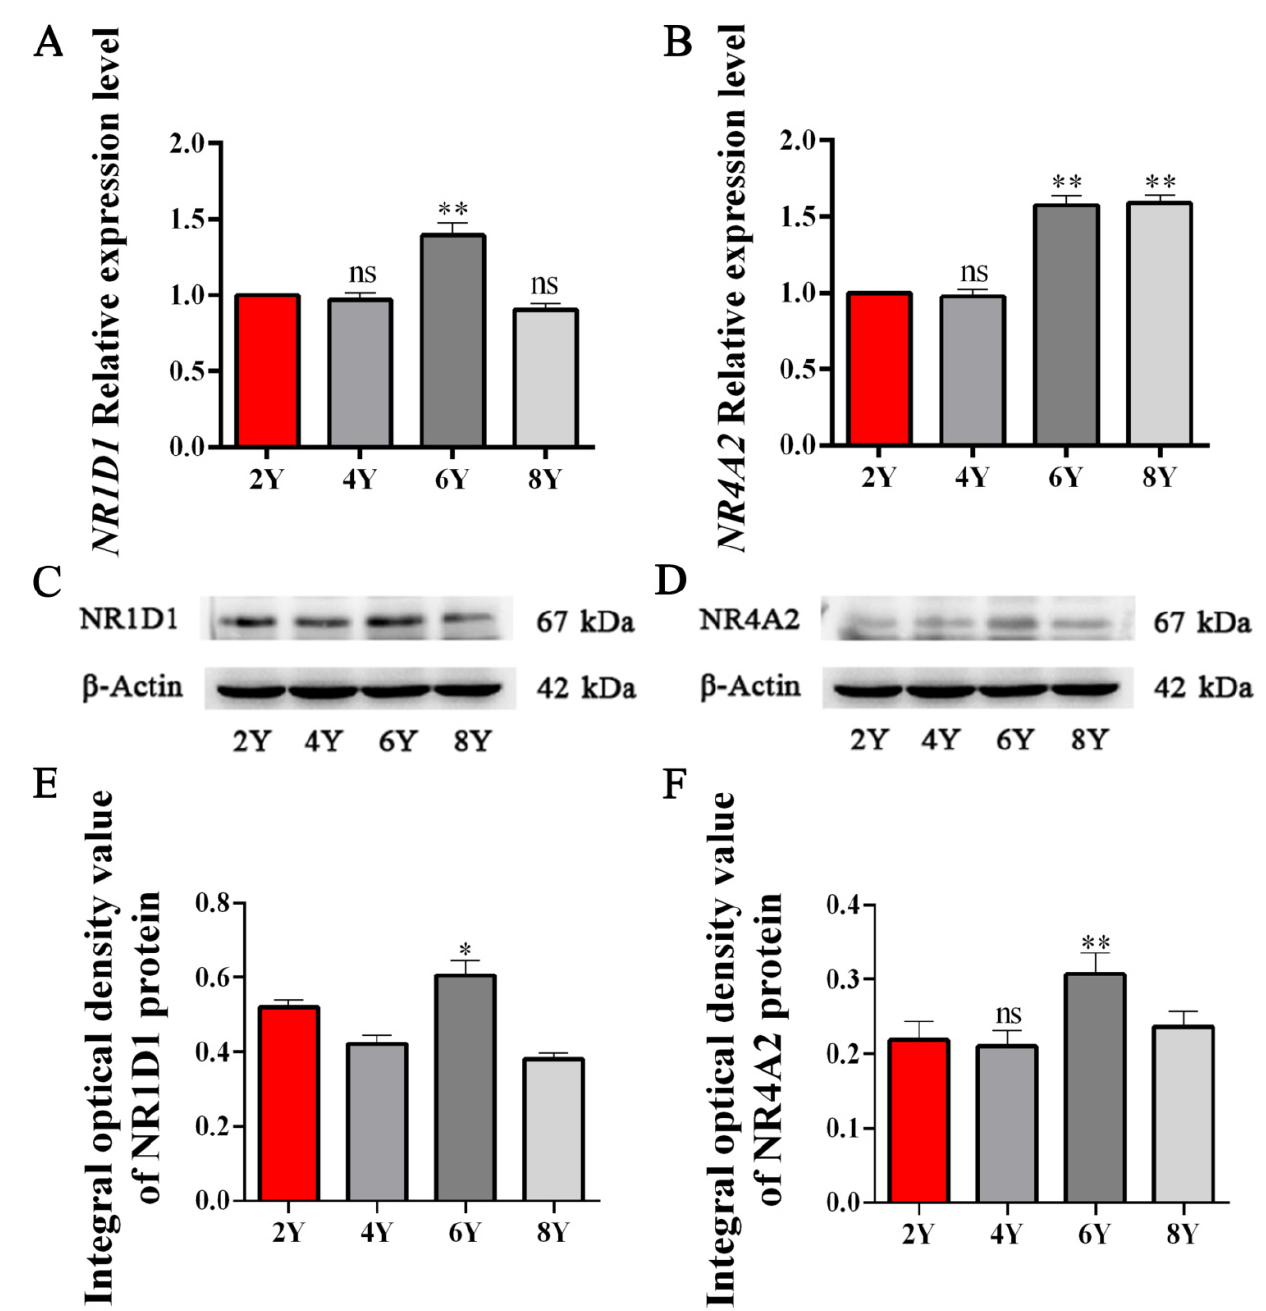
Figure 5. Expression patterns of NR1D1 and NR4A2 mRNA and protein in yak testicular tissues in animals of different ages. ( A , B ), The expression of NR1D1 and NR4A2 mRNA, respectively, in yak testicular tissues from animals of different ages, detected using qPCR. ( C , D ), The expression of NR1D1 and NR4A2 protein, respectively, detected using Western blot in yak reproductive axis tissues. ( E , F ), The IOD value of NR1D1 and NR4A2 protein, respectively, in testicular tissues from yaks of different ages. The expression levels of NR1D1 and NR4A2 mRNA and protein in testicular tissues of 2-year-old yaks were used as controls. The expression of β -actin was used as an endogenous control. *, represent significant difference vs. control ( p < 0.05), **, represent extremely significant difference vs. control ( p < 0.01). Y, Year; ns, represent NO significant difference.